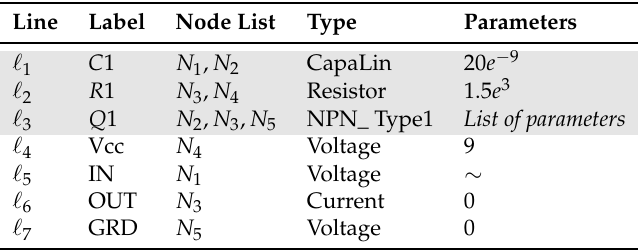
Table 1. Example of a netlist corresponding to the circuit in Figure 2. The grey part corresponds to the components, and the other elements correspond to the external ports, or sources (as in figure 2). Line Label Node List